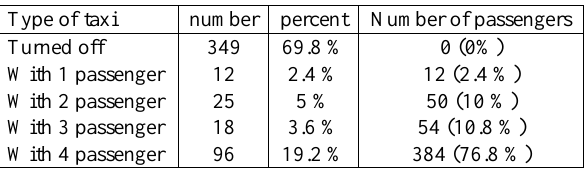
Table 1. Percentage of taxies with different number